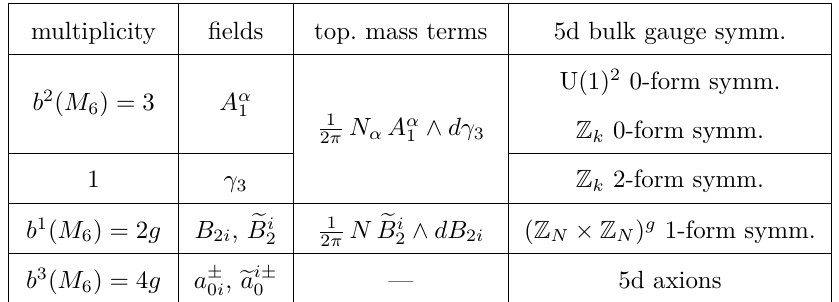
Table 2 . Summary of p -form gauge fields in 5d supergravity obtained from expansion of C 3 onto cohomology classes in M for M5-branes at a Z singularity wrapped on a genus- g Riemann surface. 6 2 We have defined k = gcd( N ) α